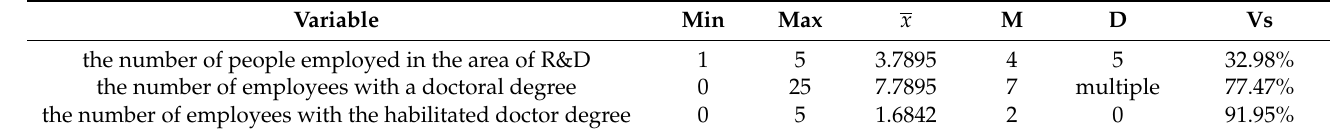
Table 5. The basic characteristics of quantitative variables.